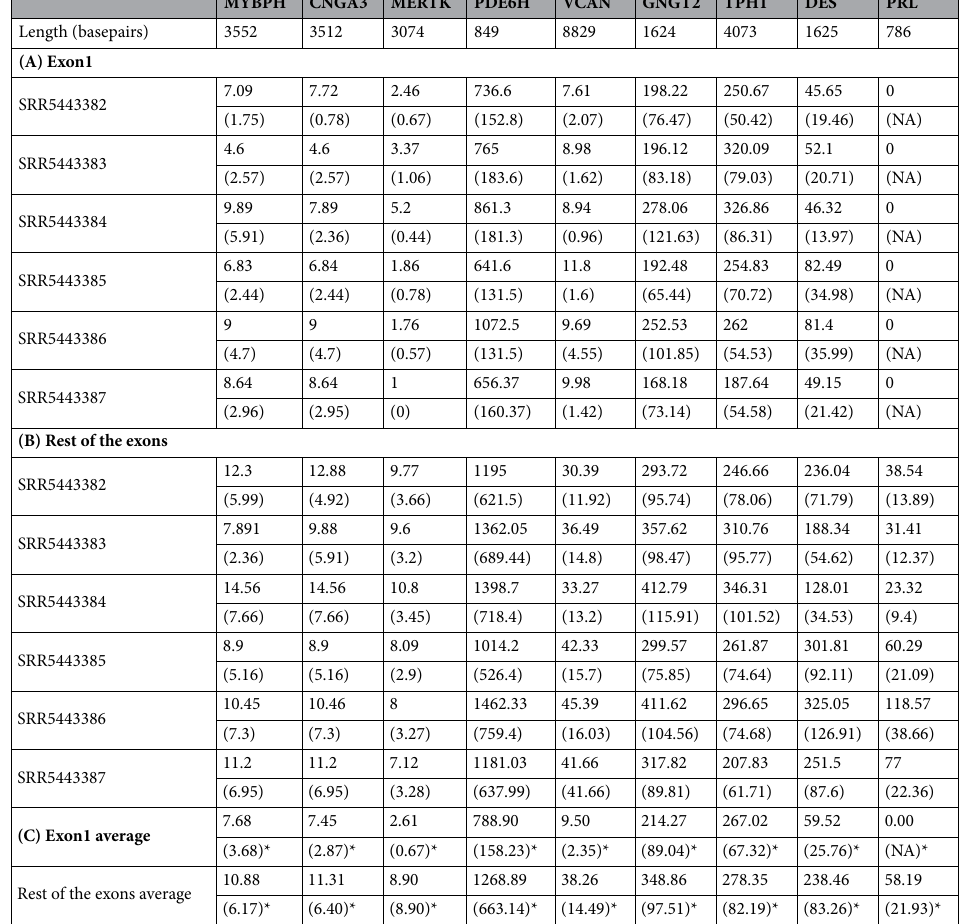
Table 1. Average coverage and standard deviations of the first exon (A), and for the remaining exons (B) of the transcripts for MYBPH, CNGA3, MERTK, PDE6H, VCAN, GNGT2, TPH1, DES, and PRL genes, for each of the six samples analyzed (IDs reported). Standard deviations are shown for each average. For all transcripts except PRL, whether the average coverage is the order of the tens or in the order of hundreds for the remaining transcripts, a coverage greater than zero is detectable for exon 1. Samples with an average coverage smaller than PRL by an order of magnitude still show a detectable exon 1. In (C), averages for the six samples are shown. Values in parentheses are standard deviations. *Indicates actual square root of the average of the square of the standard